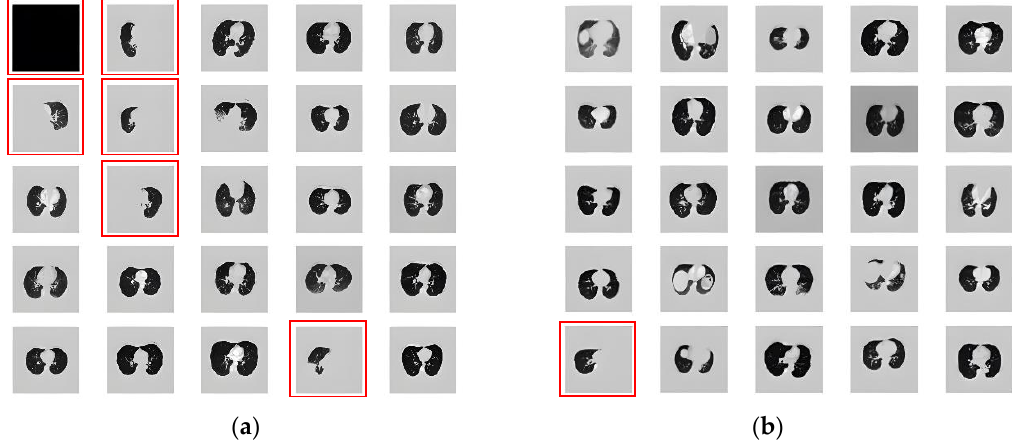
Figure 4. Random sample of pre-processed scans. ( a ) Previous method defined by [19] produces an error rate of 6/25. ( b ) Adapted solution, with new thresholding, produces an error rate of 1/25.